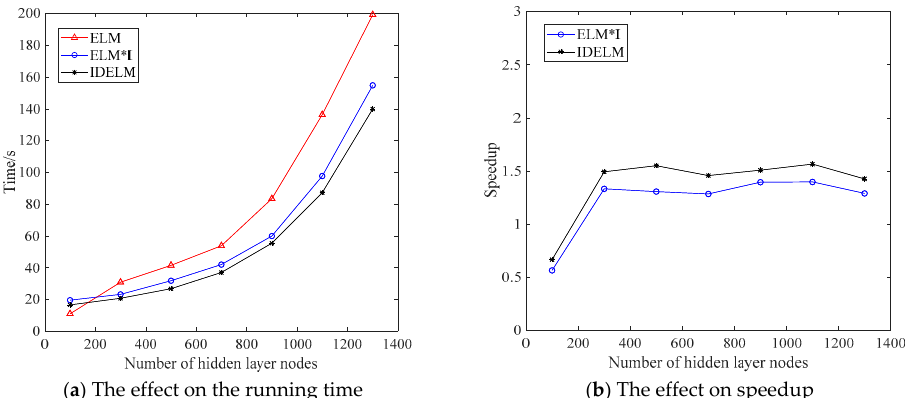
Figure 2. The effect of the number of hidden layer nodes on the running time (a) and speedup of the algorithm